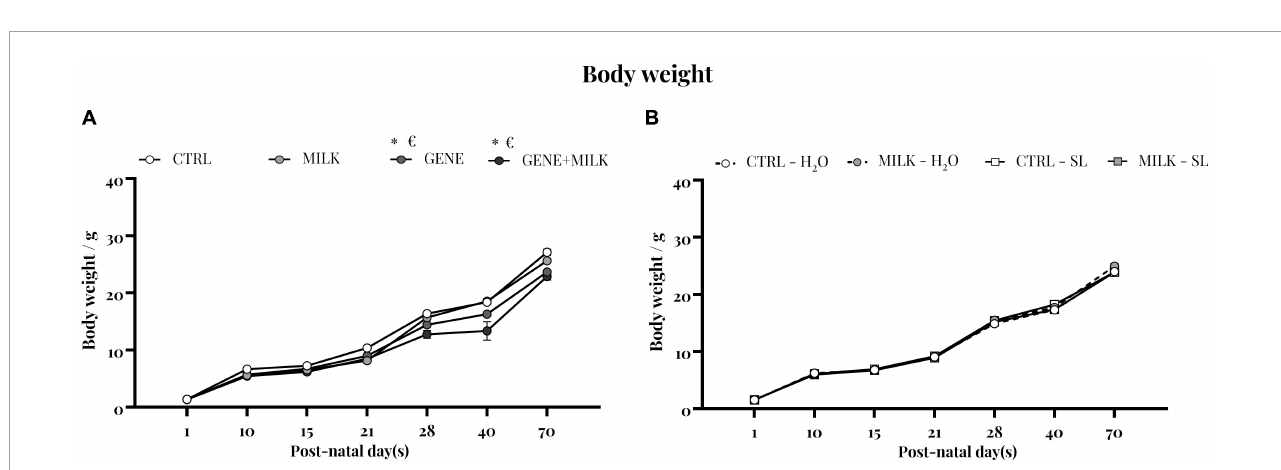
FIGURE7 Body weight: body weight measurement of experiment 1 (A) and experiment 2 (B) . ∗ p < 0.05 in post-hoc tests compared to CTRL group, € p < 0.05 in post-hoc tests compared to GENE